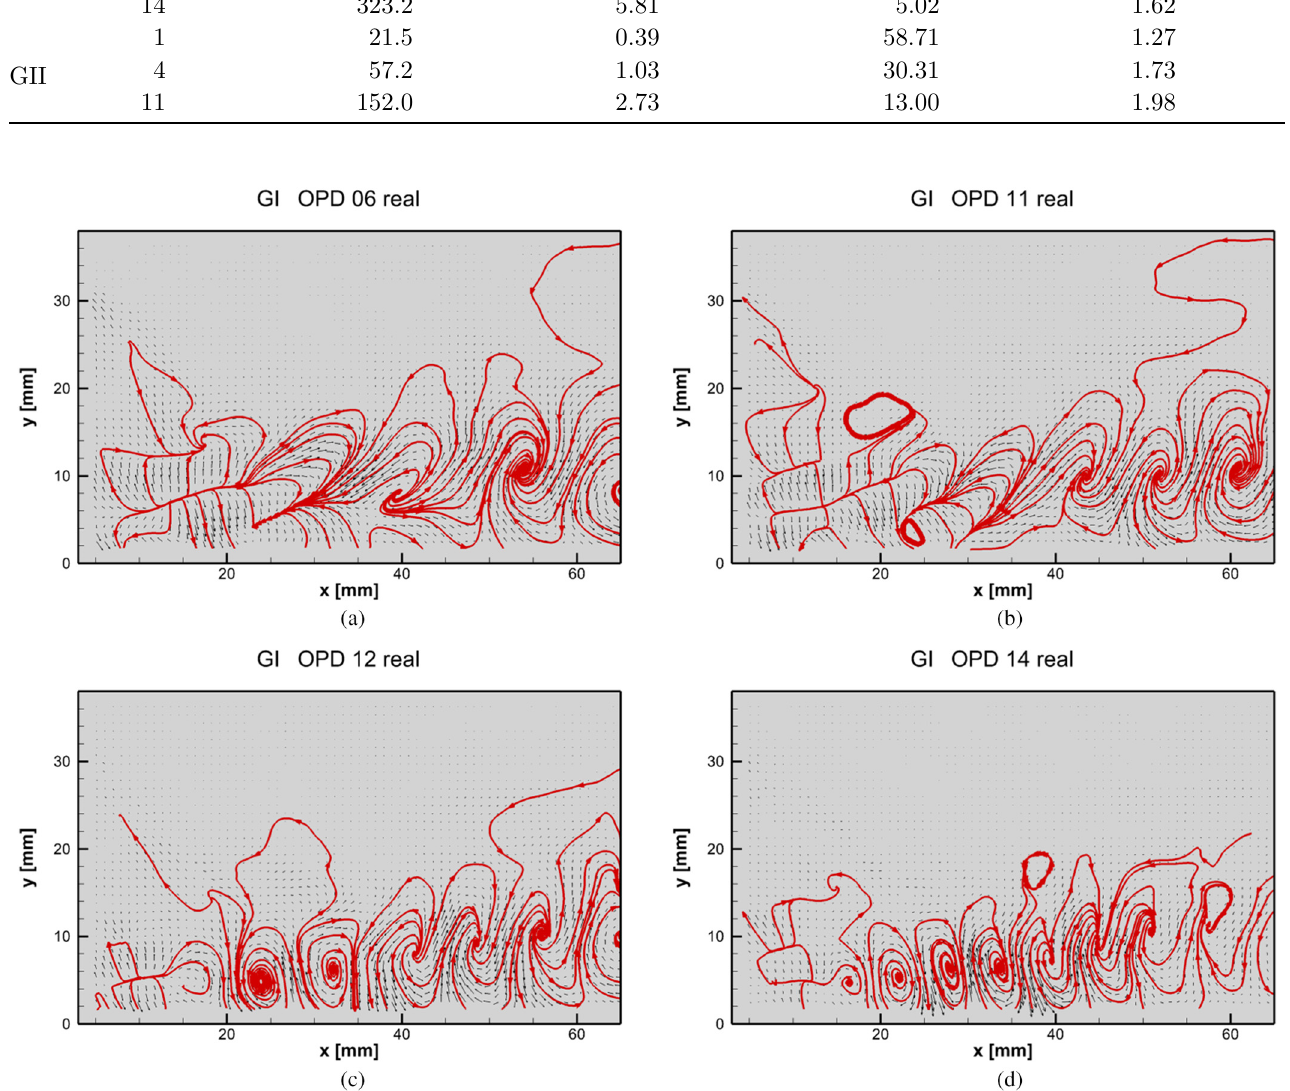
Fig. 17. Topologies of the selected OPD modes in the branch G, zone I, real parts, (a) 6, (b) 11, (c) 12 and (d)